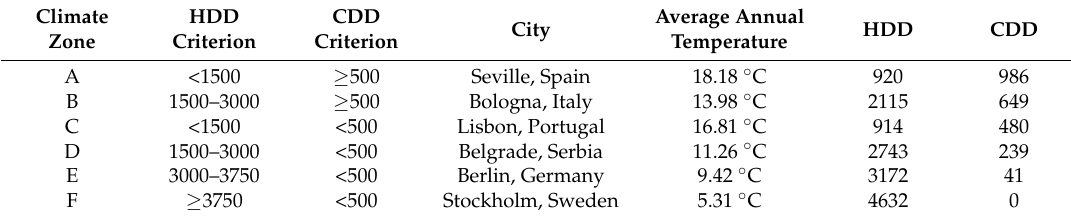
Table 4. Studied cities for each European climate zone defined by Tsikaloudaki et al. [33] (HDD,